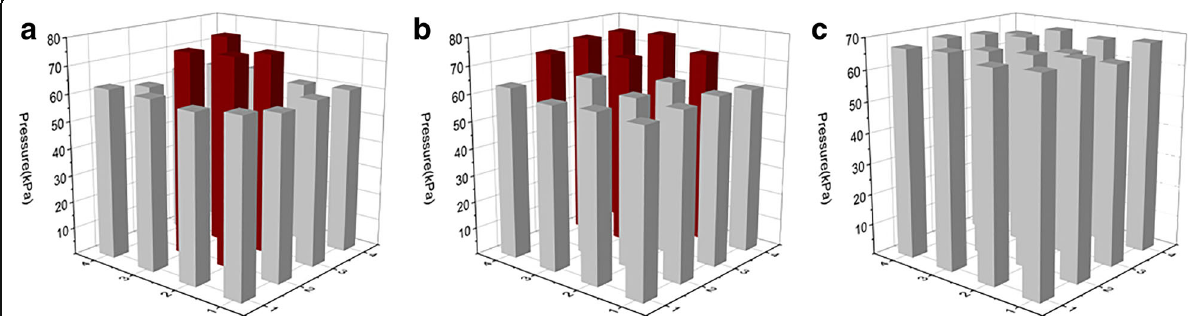
Fig. 6 The pressure state and distribution of the thumb finger movement characterized by the proposed sensor: a the shiatsu, b the kneading, and c the